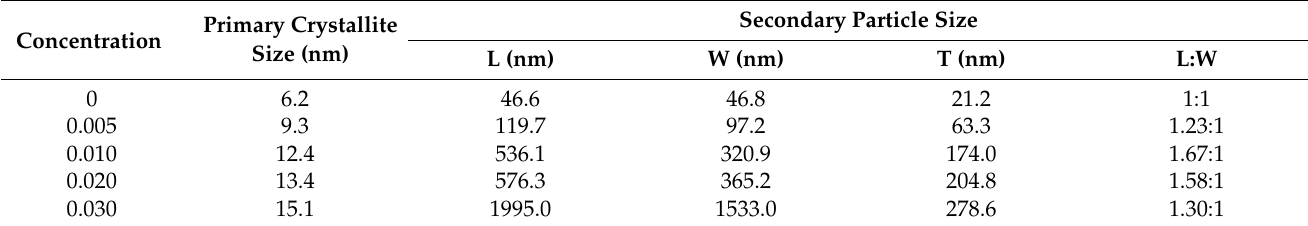
Table 1. Primary and secondary particle size of HT-ZrO 2 .